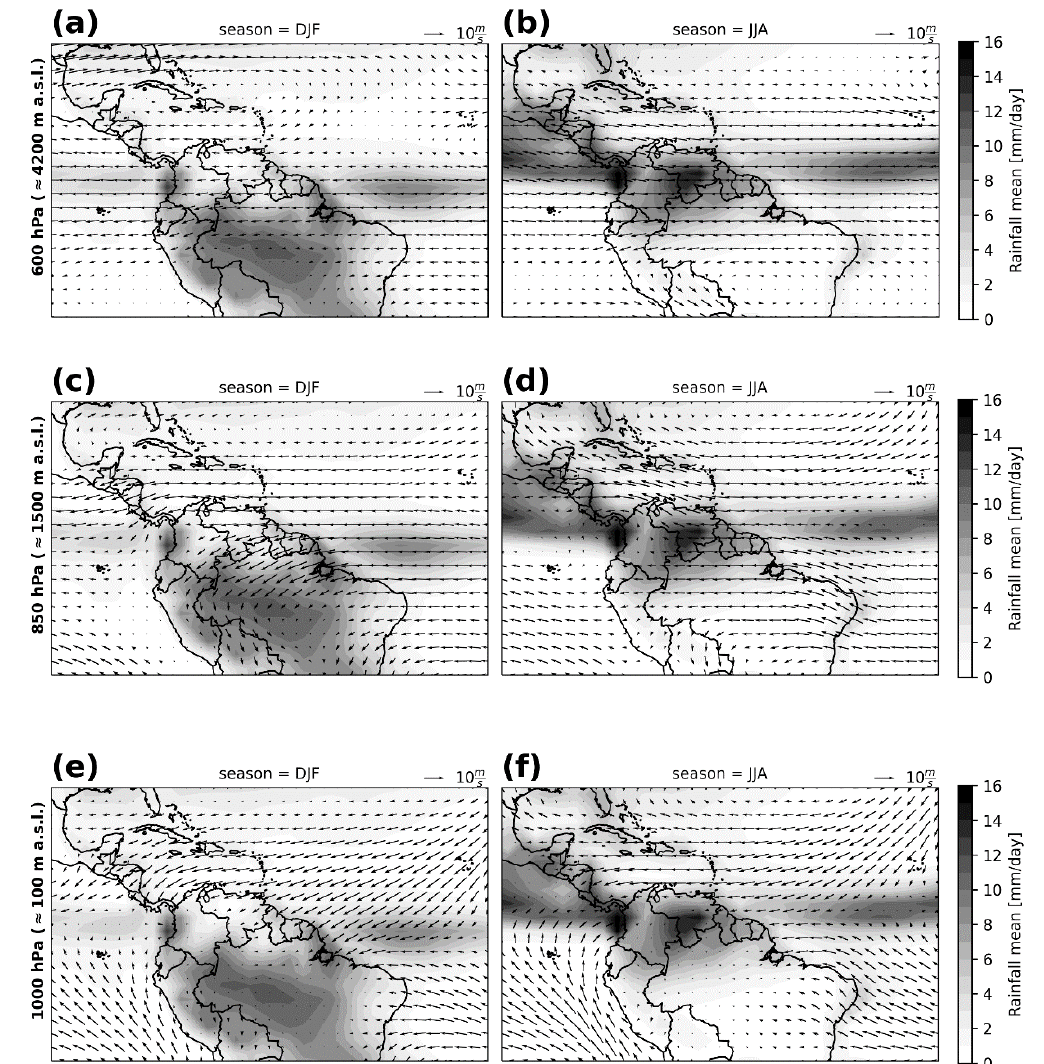
Figure 9. Mean of daily rainfall during DJF (left column) and JJA (right column) shown as colored backgrounds and the mean wind field at 600 hPa ( a , b ), 850 hPa ( c , d ), and 1000 hPa ( e , f ) (approx. 4200, 1500, and 100 m a.s.l., respectively). The precipitation data are from the Global Precipitation Climatology Project [64].